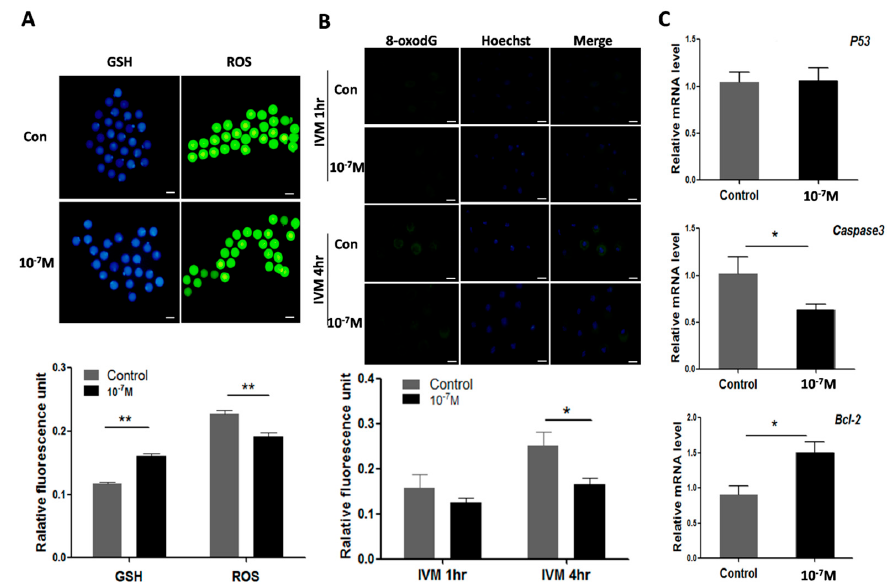
Figure 6. Effects of melatonin on ROS, GSH, 8-oxodG levels as well as apoptosis-associated genes expression in oocyte. ( A ) Effects of melatonin on levels of GSH and ROS in oocytes (mean ± SEM of 147oocytes), scale bar = 100 μ m; ( B ) Effects of melatonin on 8-oxodG levels of oocyte during IVM (mean ± SEM of 198 oocytes), scale bar = 100 μ m; ( C ) Effects of melatonin on the expression of apoptosis-associated genes. “*” represent significant differences, p < 0.05; “**” represent significant differences, p < 0.01.